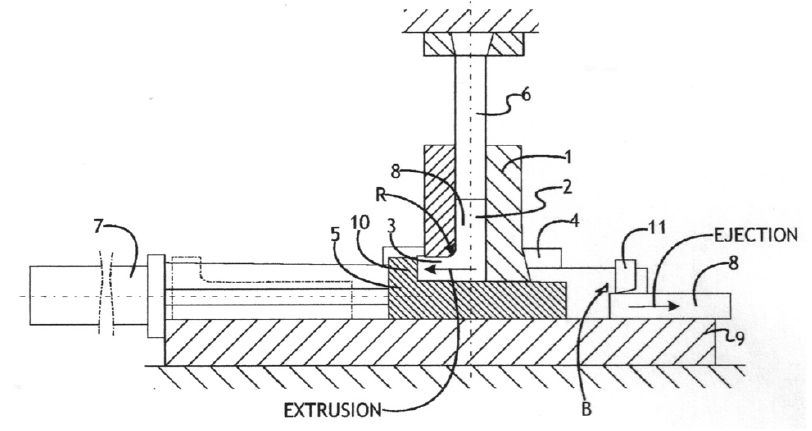
Figure 1. Schematic of the tooling design for semi-continuous equal-channel angular extrusion (sc-ECAE).